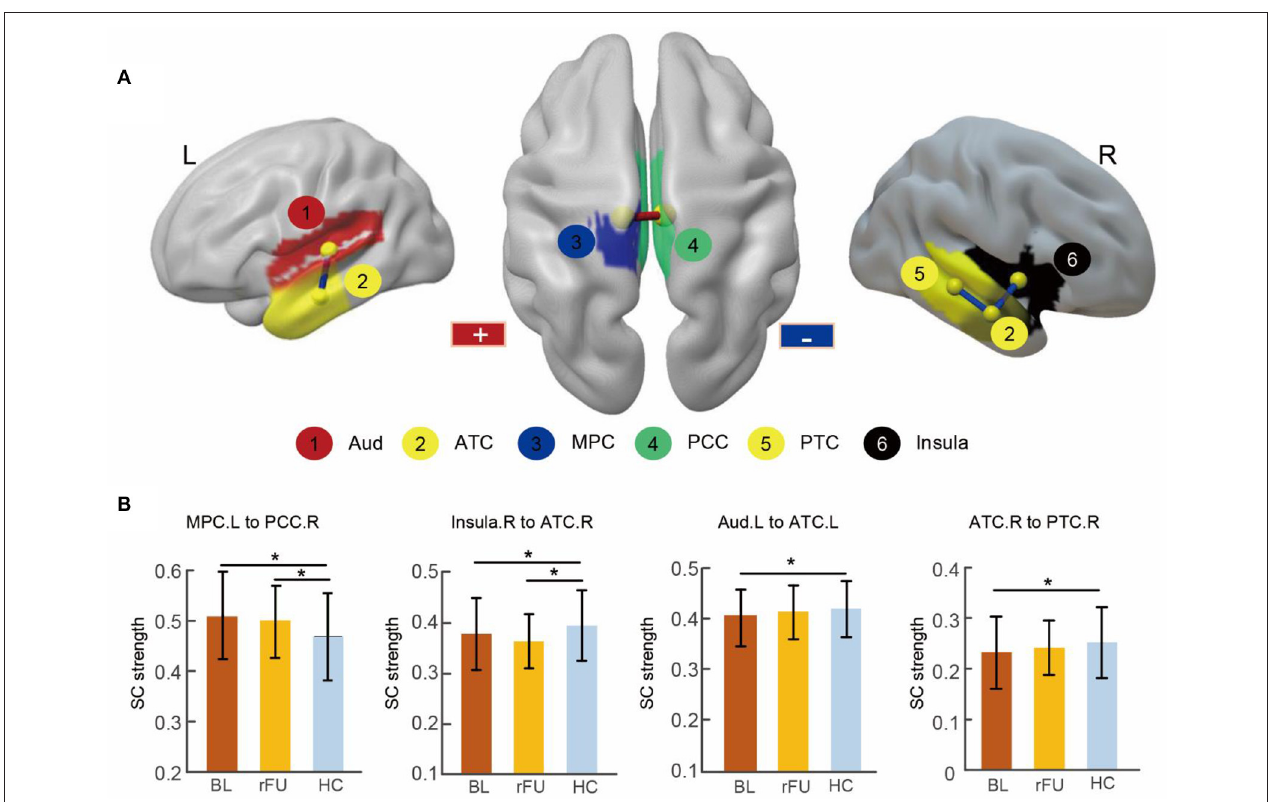
FIGURE 2 | Abnormal SC in MDD patients at baseline and remitted patients at follow-up. (A) Three-dimensional representations of the abnormal connectivity in patients at baseline. The regions were mapped onto the cortical surface at a lateral and superior view. The red line represents increased SC in patients at baseline, blue lines represent decreased SC in patients at baseline. (B) The bar figures showed the connectivity strengths across the three groups. * Two-sample t -tests ( p < 0.05, FDR corrected). BL, MDD patients at baseline; rFU, remitted MDD subgroup at follow-up; HC, healthy control group; L, left; R, right; Aud, auditory cortex; ATC, anterior temporal cortex; MPC, medial parietal cortex; PCC, posterior cingulate cortex; PTC, posterior temporal